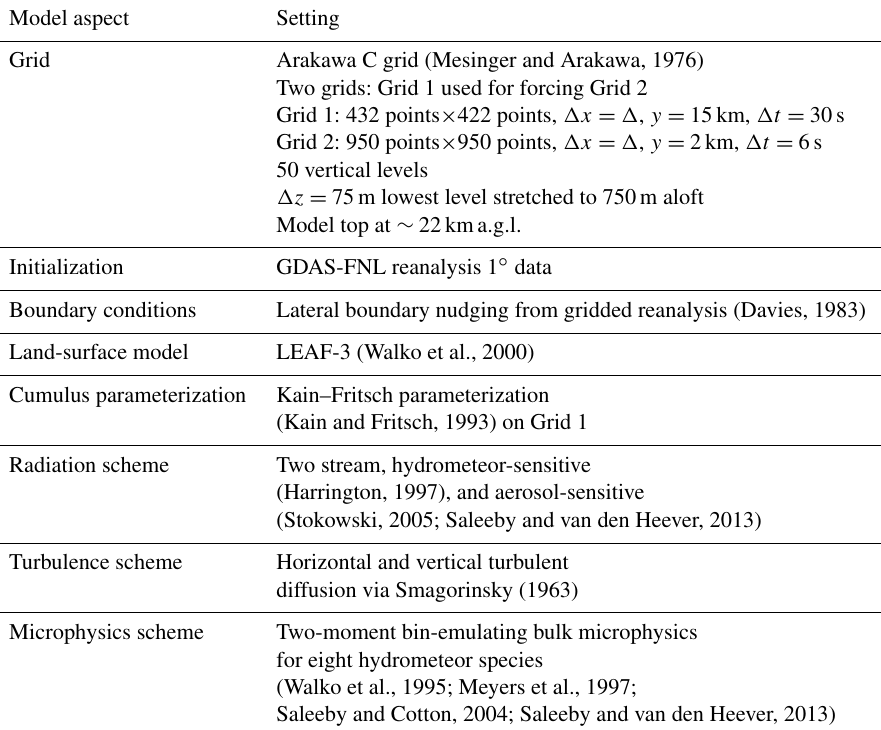
(cid:49)z = 75m lowest level stretched to 750m aloft Model top at ∼